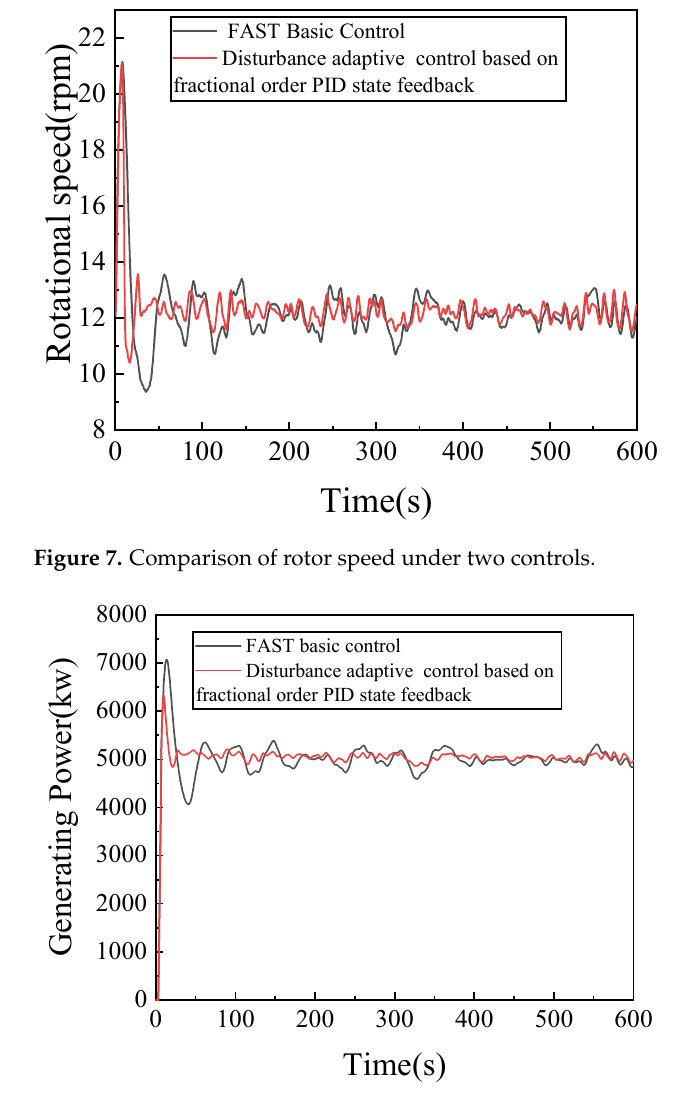
Figure 8. Comparison of power generation under two controls. Table 3. Control effect parameters under different controllers.